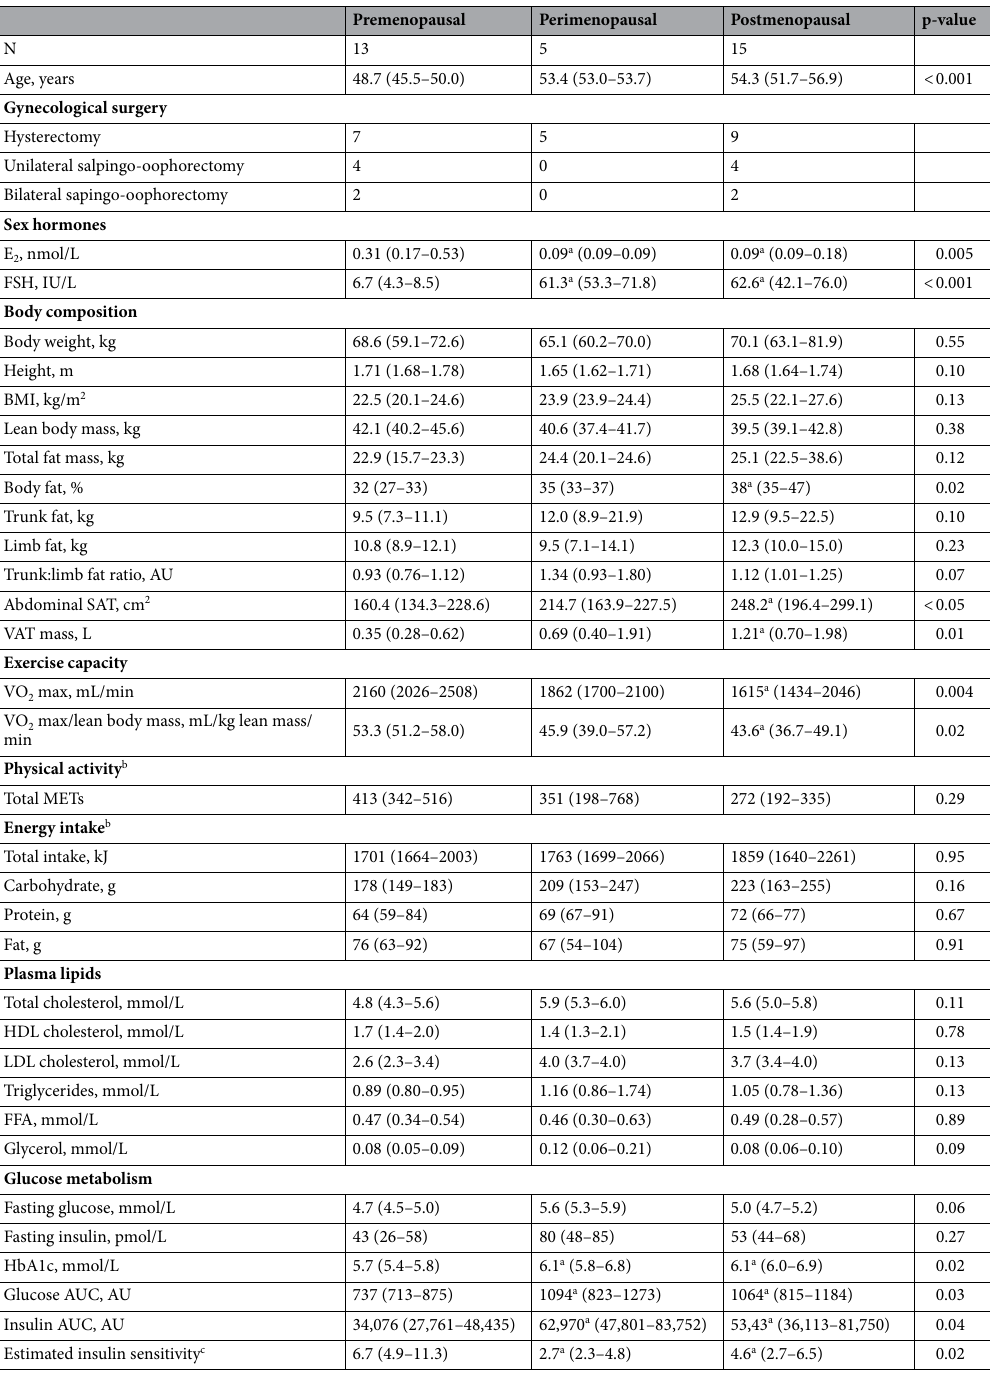
Table 1. Subject characteristics. Data are presented as median (interquartile range). E 2 estradiol, FSH follicle stimulating hormone, IU international units, AU arbitrary units, BMI body mass index, SAT subcutaneous adipose tissue, VAT Visceral adipose tissue, L liter, VO 2 max maximum oxygen uptake, MET Metabolic equivalents, LDL low-density lipoprotein, HDL high-density lipoprotein, FFA free fatty acids, AUC area under the curve. a Significantly different from premenopausal, p < 0.05. b Self-reported. c Estimated insulin sensitivity calculated through Composite Matsuda